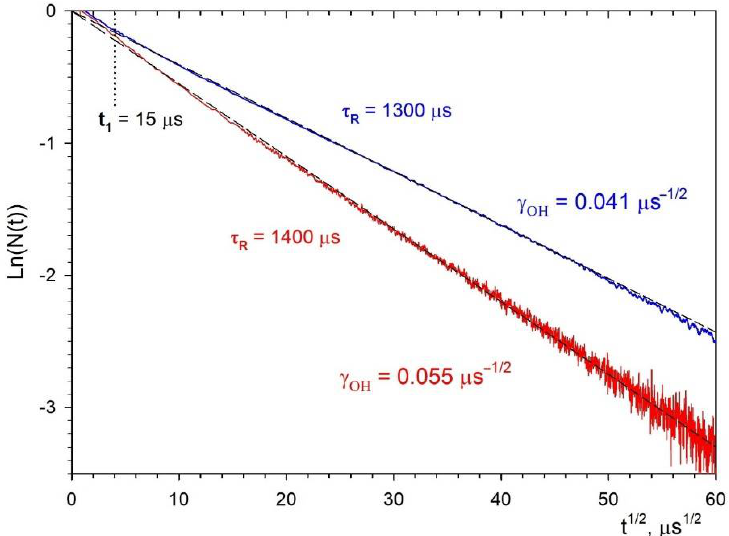
Figure 9. The static quenching kinetics of luminescence of the 4 F 3/2 level of the Nd 3+ ion for an aqueous colloidal solution of 0.1% at.% Nd 3+ : LaF 3 NPs: type I (red curve) and type II (blue curve). Black dashed lines are Förster kinetics N ( t ) = exp